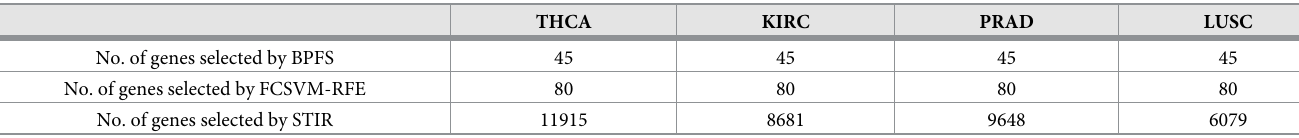
Table 6. Number of genes selected.